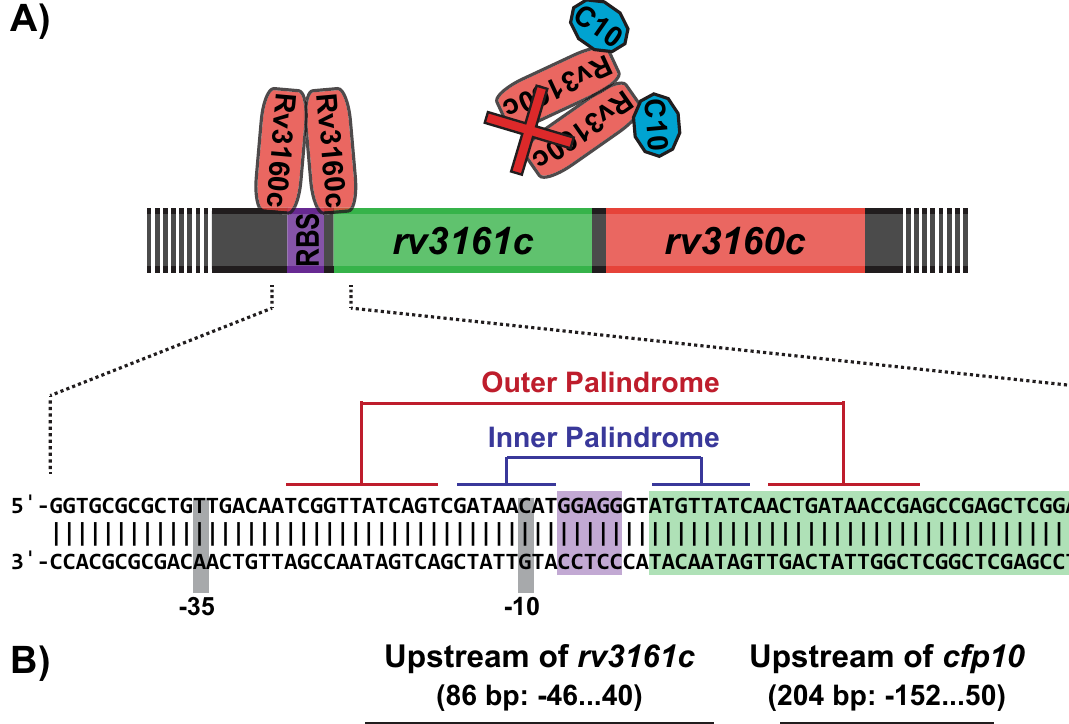
Inner 5̍-GGTGCGCGCTGTTGACAATCGGTTATCAGTCGATAACATGGAGGGTATGTTATCAACTGATAACCGAGCCGAGCTCGGAGACATCC-3̍ |||||||||||||||||||||||||||||||||||||||||||||||||||||||||||||||||||||||||||||||||||||| 3̍-CCACGCGCGACAACTGTTAGCCAATAGTCAGCTATTGTACCTCCCATACAATAGTTGACTATTGGCTCGGCTCGAGCCTCTGTAGG-5̍